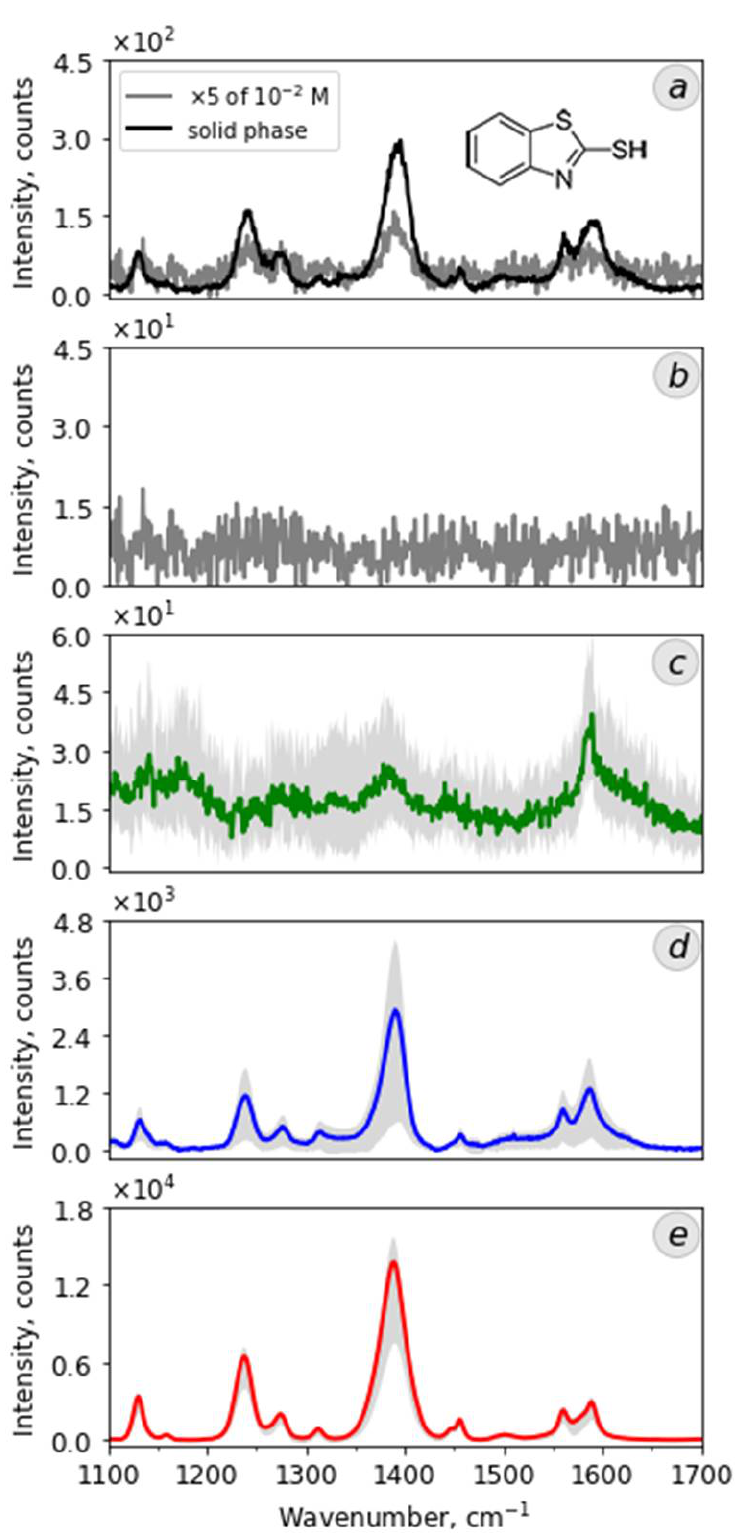
Figure 6. Raman spectra of MBT (( a )—solid phase and 10 − 2 M, ( b )—10 − 6 M) and SERS ( c – e ) spectra of MBT with a concentration of 10 -6 M, obtained on the surface of silver nanostructures (( c ), crystallites; ( d ) "sunflowers"; ( e ) dendrites) in the pores of the SiO 2 /Si template.